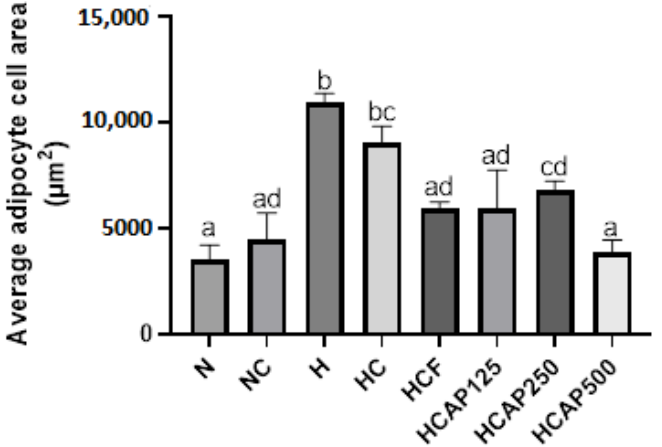
Figure 6. Impact of A. paniculata on the average adipocyte cell area of treated rats. The data are given as mean ± SE. Mean values with distinct alphabetical letters were significantly different at p < 0.05. (ANOVA, Tukey ’ s post hoc). N, normal diet; NC, normal diet + DMH; H, HFD; HC, HFD + DMH; HCF, HFD + DMH + 5-FU; HCAP125, HFD + DMH + 125 mg/kg A. paniculata ethanol extract; HCAP250, HFD + DMH + 250 mg/kg A. paniculata ethanol extract; HCAP500, HFD + DMH + 500